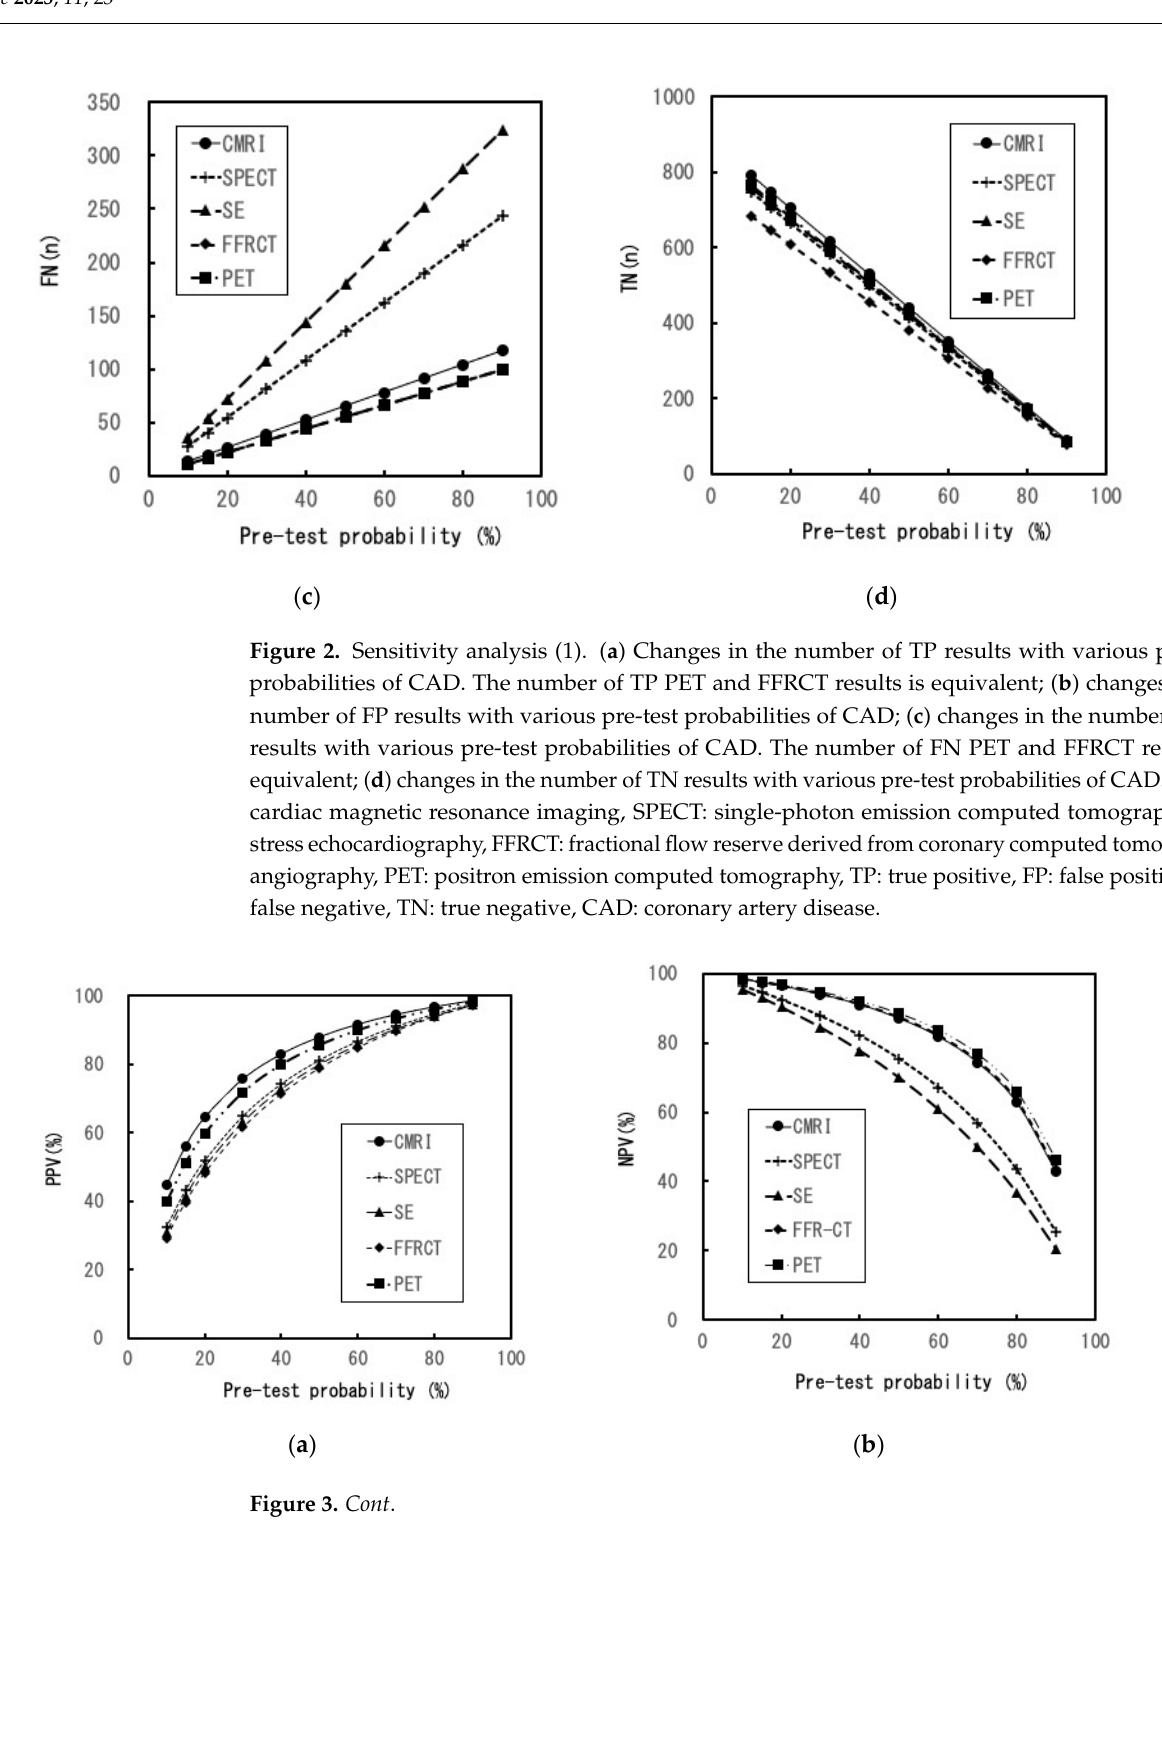
Figure 3. Sensitivity analysis (2). ( a ) Changes in PPV with various pre-test probabilities of CAD; ( b ) changes in NPV with various pre-test probabilities of CAD; ( c ) changes in post-test probability with various pre-test probabilities of CAD, Upper: post-test probability (for positive result), Under: post- test probability (for negative result); ( d ) changes in the diagnostic accuracy with various pre-test probabilities of CAD; CMRI: cardiac magnetic resonance imaging, SPECT: single-photon emission computed tomography, SE: stress echocardiography, FFRCT: fractional flow reserve derived from coronary computed tomography angiography, PET: positron emission computed tomography, CAD: coronary artery disease, PPV: positive predictive value, NPV: negative predictive value. 4. Discussion We evaluated and compared the efficiencies of five non-invasive diagnostic imaging modalities for the detection of myocardial ischemia in patients suspected of having SA. Our findings that could be useful to patients were as follows: Among the five types of modalities in the basic settings (PTP: 30%), •